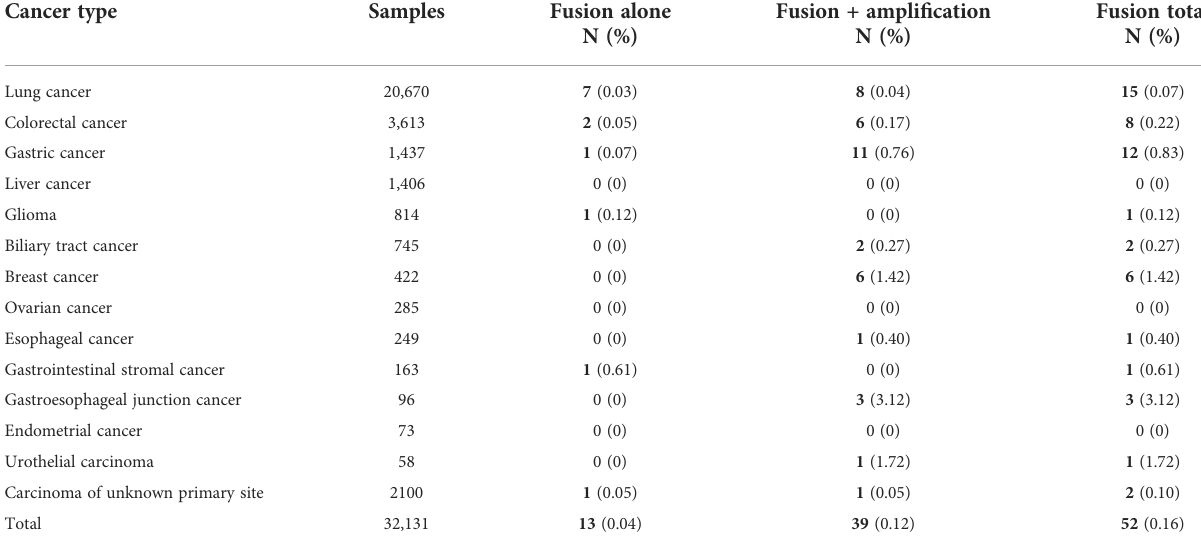
TABLE 4 Frequencies of ERBB2 alternations and relative distribution of alternation types in 52 ERBB2-KD fusion solid tumors from Chinese cohort.